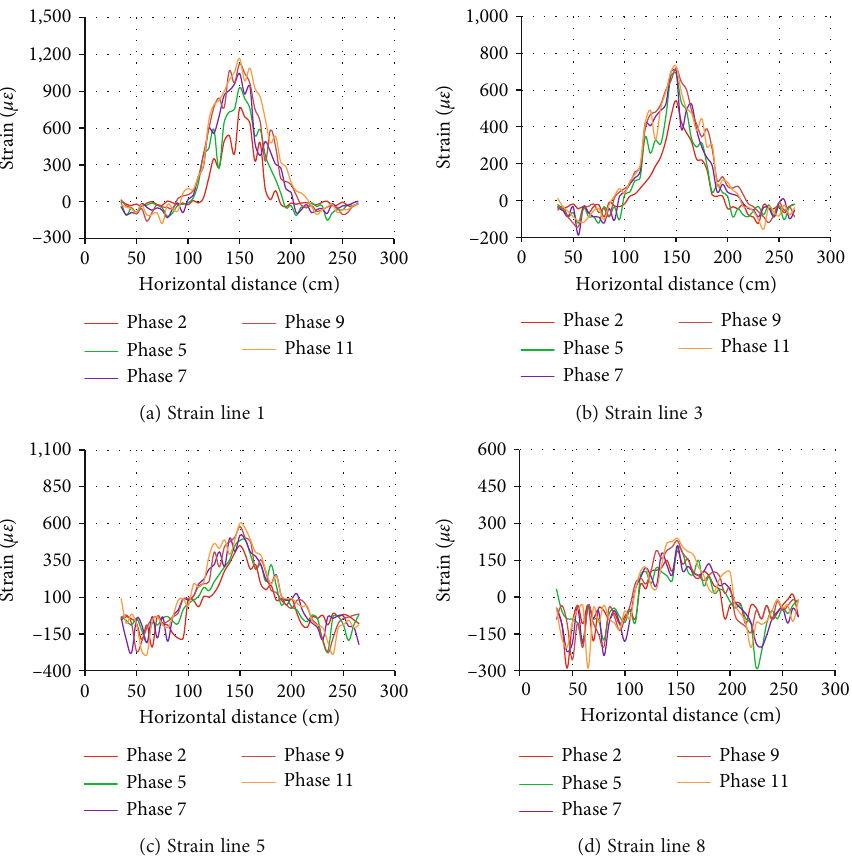
Figure 11: Strain curve chart of overlying strata in di ff erent loading phases after the fl oor roadway